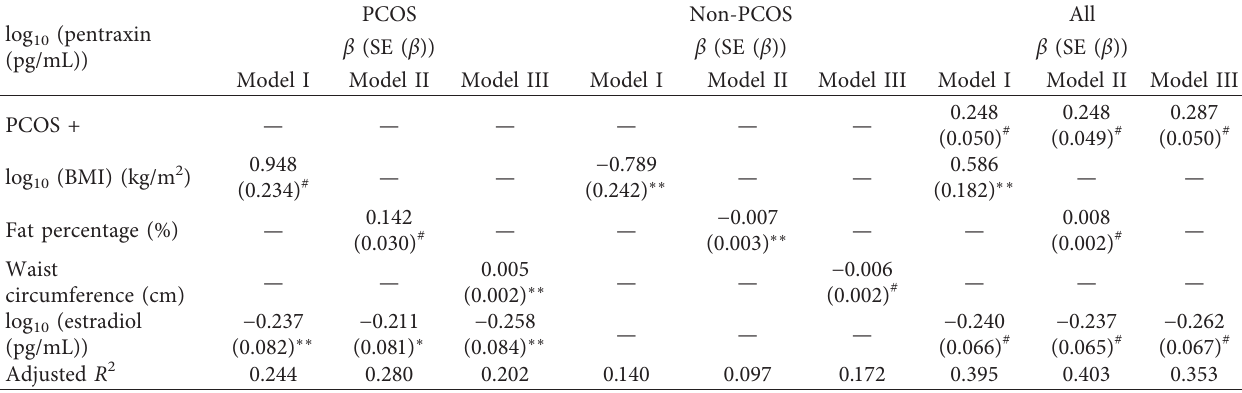
Table 2: Results of multivariable stepwise backward regression factors influencing PTX3 serum levels in subjects with and without PCOS. log 10 (pentraxin